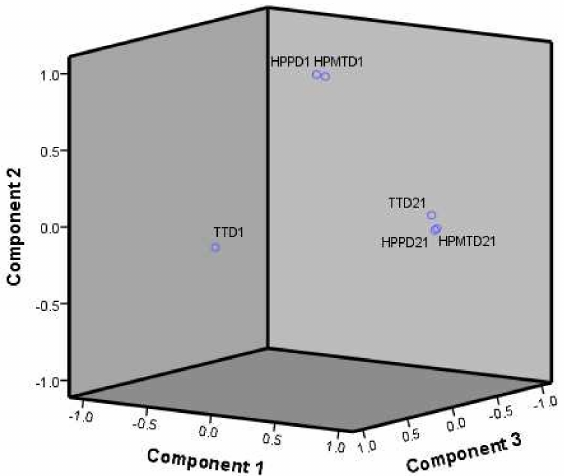
Figure 4. The 3D plot of the principal components (PCs) and their internal structure resulted from EFA, with Varimax